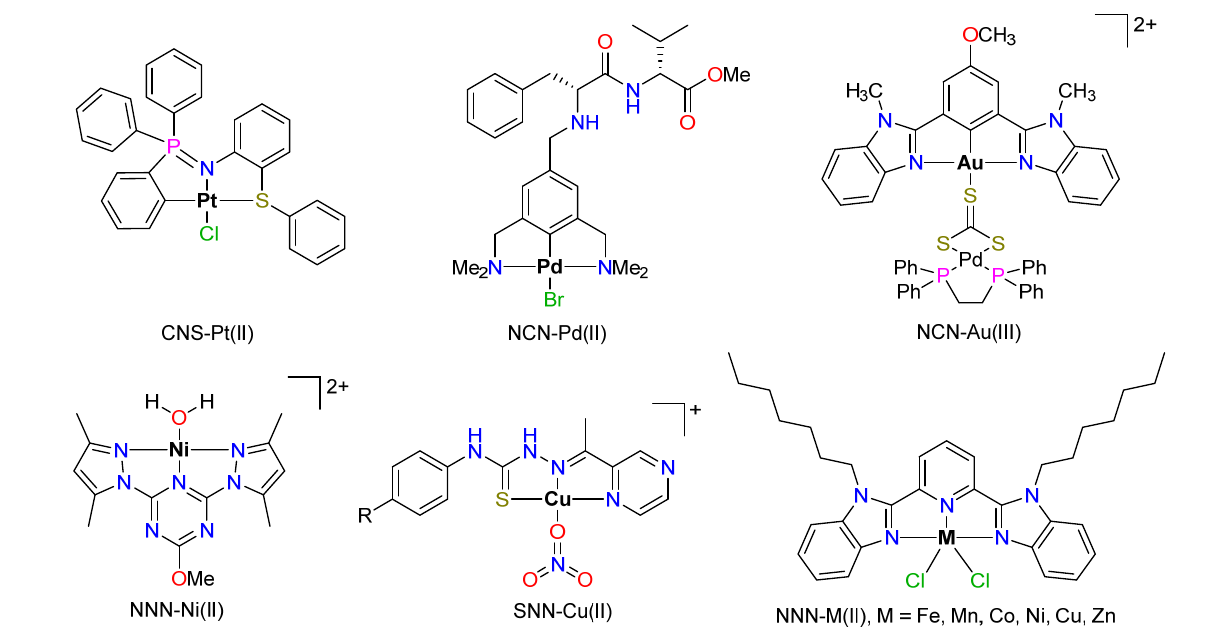
Figure 1. Pincer complexes with tridentate ligands that have shown biological activity.